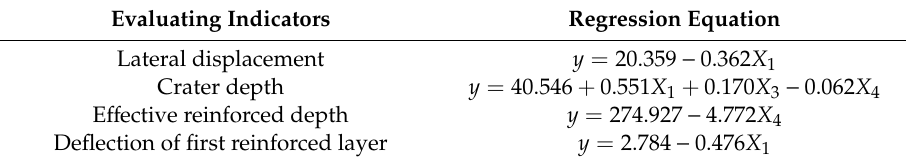
Table 11. Multiple linear regression analysis of evaluated